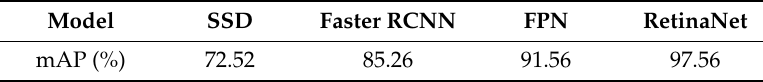
Table 3. The ship detection mAP of four